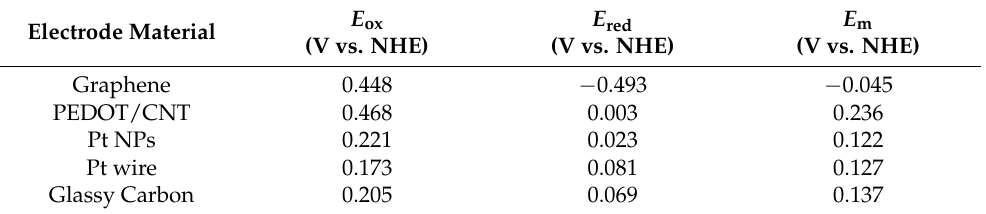
Table 2. Electrochemical parameters of aqueous Co II/III redox mediator with varying